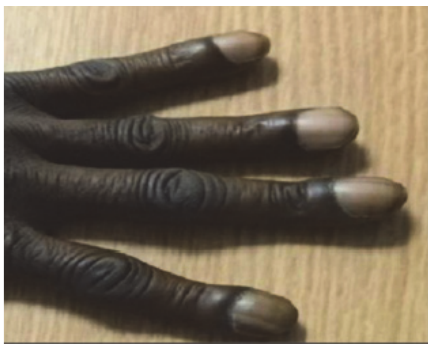
Figure 1: Severe digital clubbing.